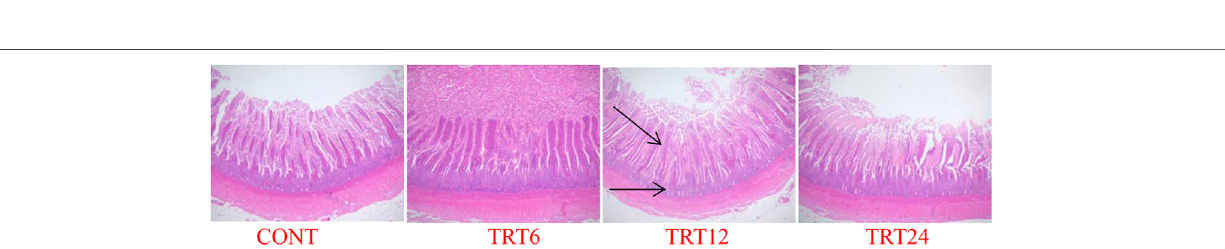
FIGURE1| Lightmicrographofjejunummorphologyinmeatgeese(40×multiple).Controlgeese(CONT)werefedabasaldiet,whereasTRT6,TRT12,andTRT24 were fed a basal diet supplemented with 6, 12, or 24% alfalfa-mixed silage fermented material, respectively.